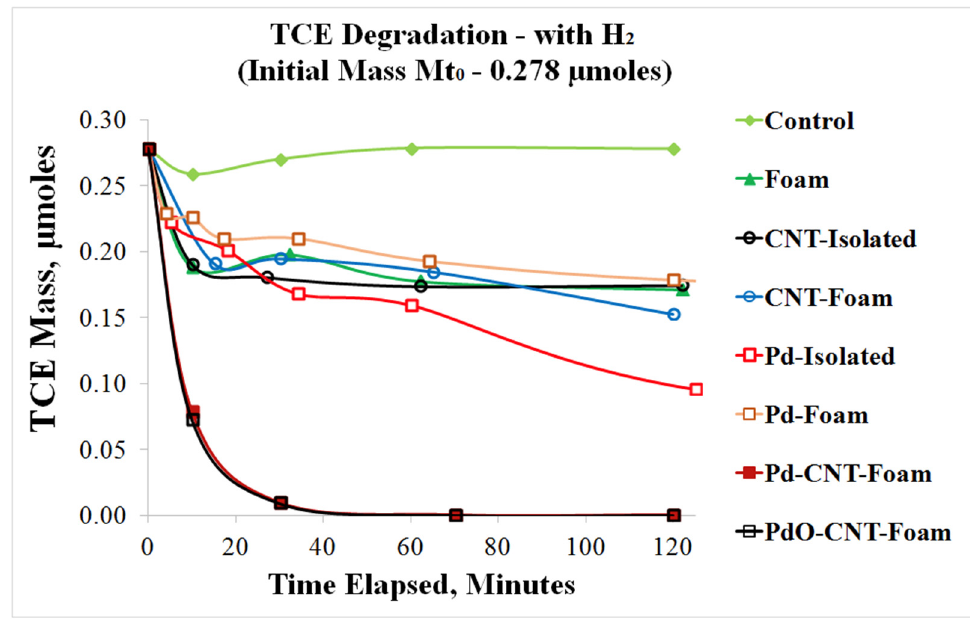
Figure 9. Dechlorination profile of TCE using various catalysts. It must be noted that the nanoparticles of Pd and PdO attached to CNT-Foam show rapid and complete degradation that is not seen in any of the controls, including isolated Pd (loose nanoparticles) “Reproduced with permission from [157]. MDPI, 2016.”